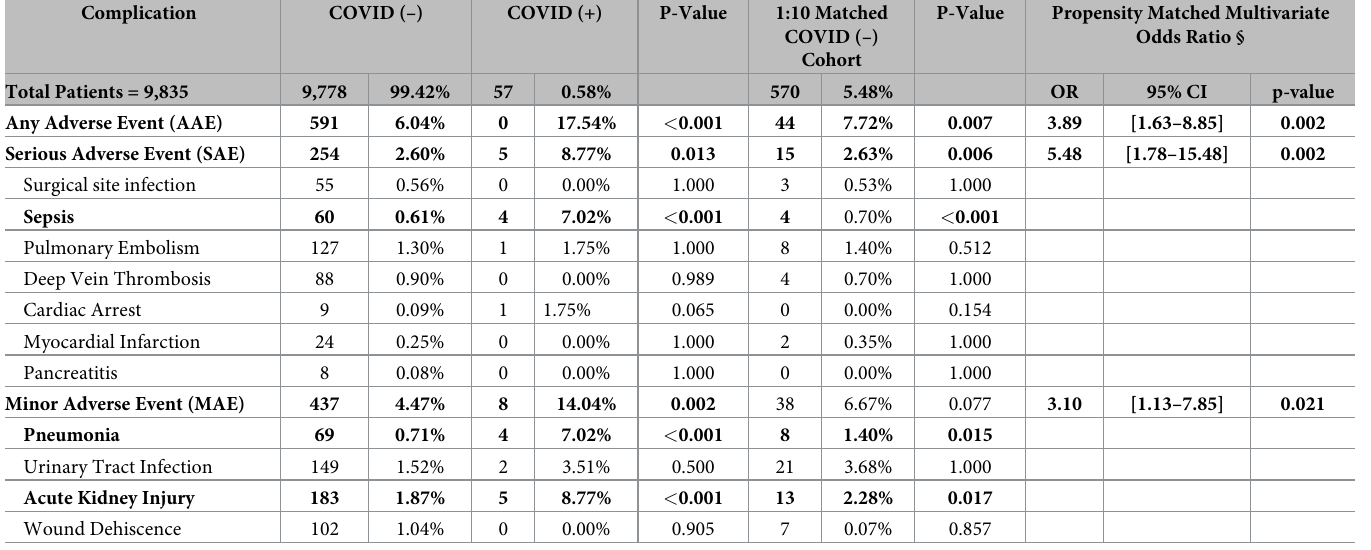
Adverse events Adverse events occurring within the 30-day postoperative period were tabulated and com- pared by univariate analyses for the full groups and propensity matched groups and multivari- ate for the propensity matched groups (Table 3). For the full groups, based on univariate analyses, COVID-positive patients had higher rates of any adverse events (17.54% compared Table 3. Adverse events breakdown by COVID